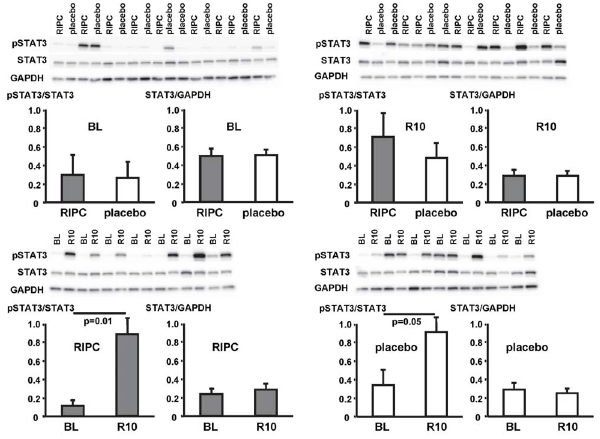
Figure 8. Activation of signal transducer and activator of transcription 3 (STAT3) by ischemia/reperfusion. Original West- ern blots of phosphorylated (p) and total STAT3 content in myocardial biopsies obtained at baseline (BL) before initiation of cardiopulmonary bypass and at 5–10 min reperfusion (R10) from patients undergoing remote ischemic preconditioning (RIPC) or not (placebo). Immunor- eactivitiy of pSTAT3 was normalized to the respective total protein. Ratios are presented in bar graphs.